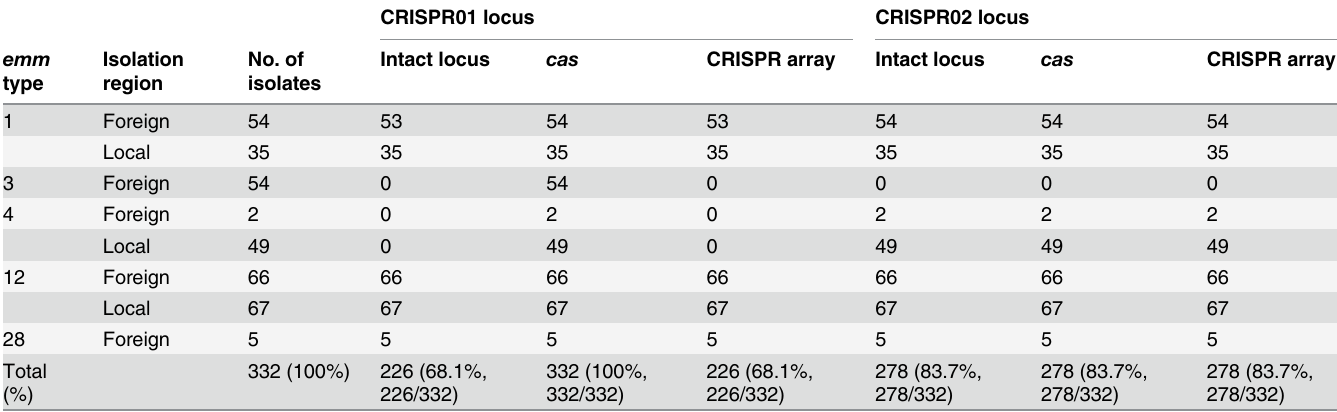
Table 1. The prevalence of cas cassettes and CRISPR arrays in different emm types and regions of